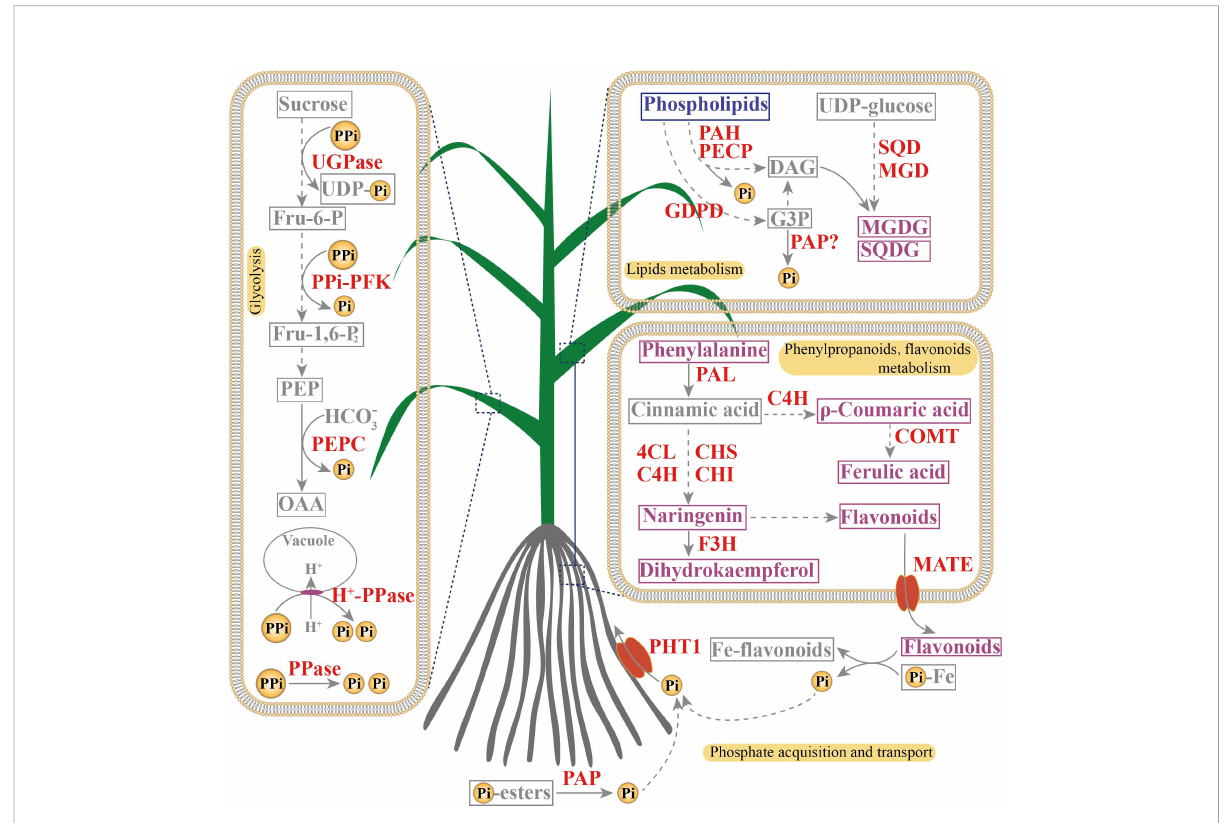
FIGURE 8 A proposed model of adaptive strategies to Pi de fi ciency in leaves and roots of elephant grass. Red indicate genes whose expression levels were up- regulated by Pi starvation. Purple and blue indicate metabolites whose accumulation increased (purple) or decreased (blue) in response to Pi de fi